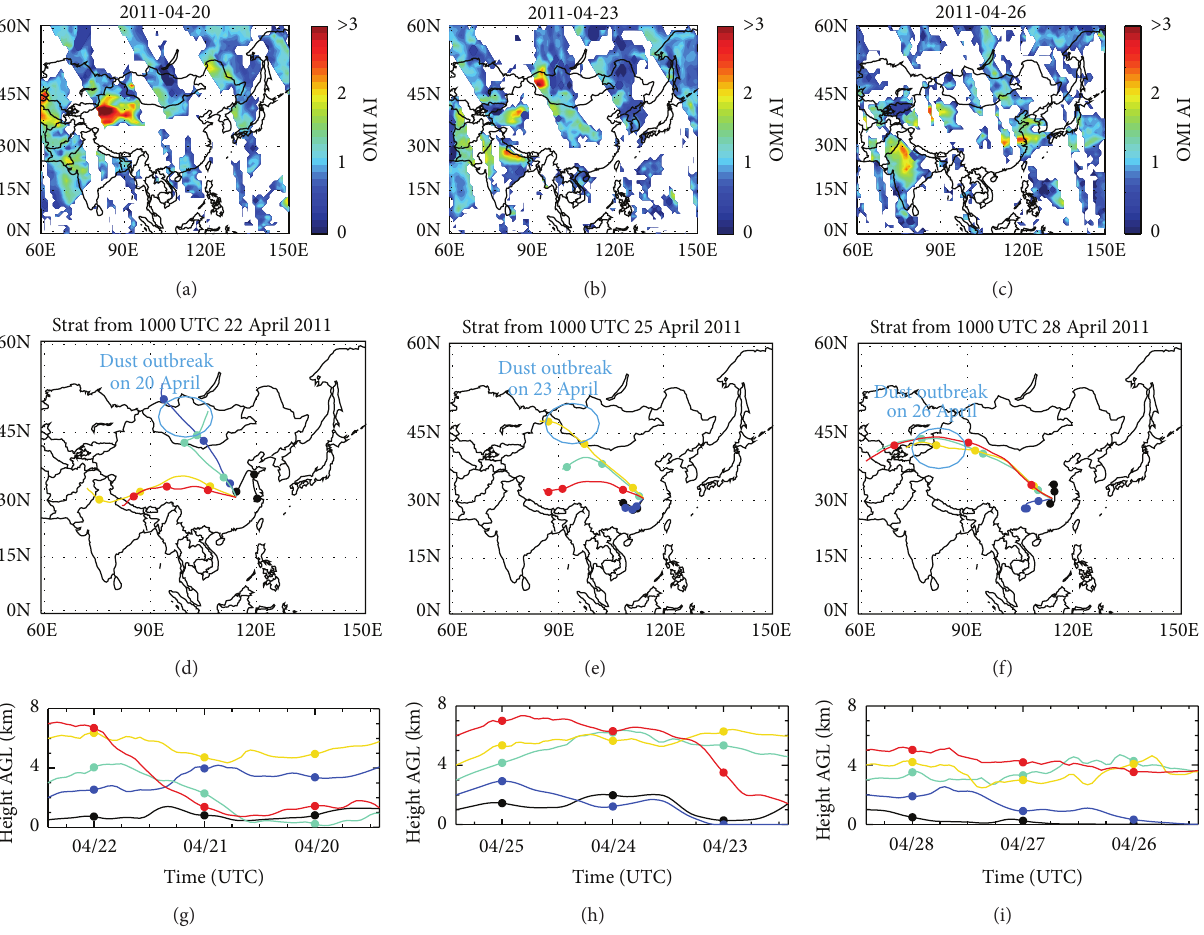
Figure 3: Aura OMI Aerosol Index (AI) distribution over East China on (a) 20 April 2011, (b) 23 April 2011, and (c) 26 April 2011. Three-day back-calculated trajectories starting at Wuhan (30.5 ∘ N, 114.4 ∘ E) from 1000UTC on (d) 22 April 2011 (at 0.5 km, 2km, 3 km, 6km, and 7